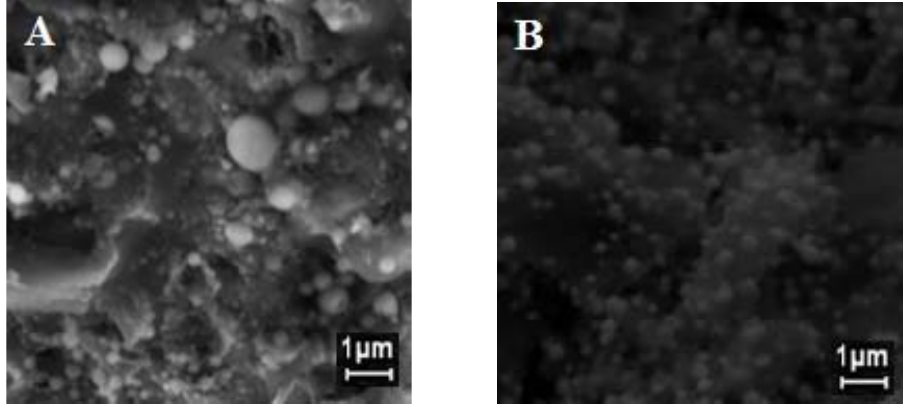
Figure 8. In vitro antibiotic release out of Ery-PLA/Ery-PLGA nanoparticles.